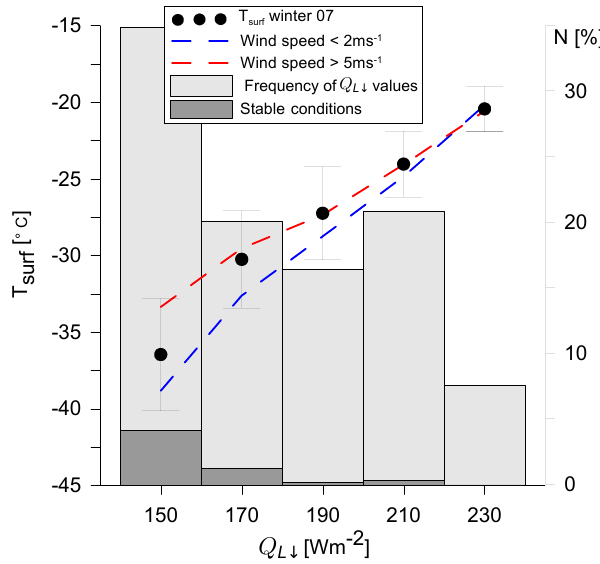
Fig. 7. The surface temperature T surf in dependence to the incom- ing long-wave radiation Q L ↓ and different wind speeds during the polar winter period 2007. The first histogram (light grey) indicates the frequency of observations that feature the displayed classes of incoming long-wave radiation. The second histogram (dark grey) shows the occurrence of stable atmospheric stratification under the different Q L ↓